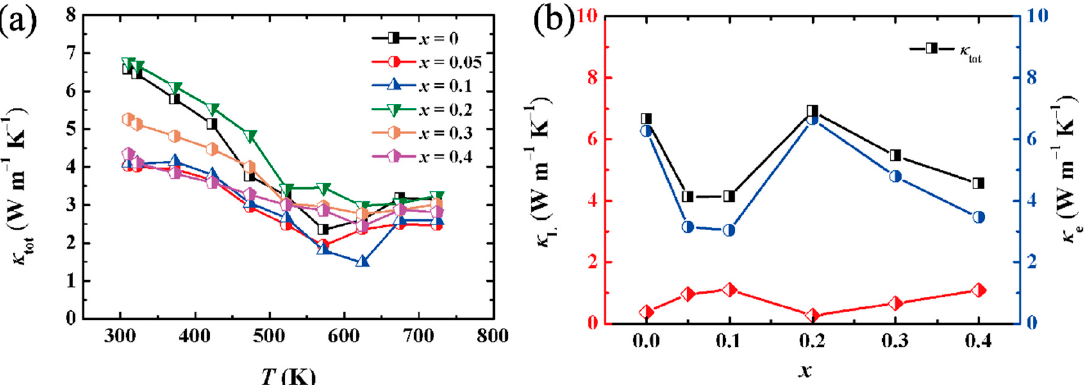
Figure 5. ( a ) Thermal conductivity of (Cu 2 Te) 1 − x -(BiCuTeO) x as a function of temperature. ( b ) Lattice thermal conductivity ( κ L ) and carrier thermal conductivity ( κ e ) as a function of BiCuTeO content at room temperature.